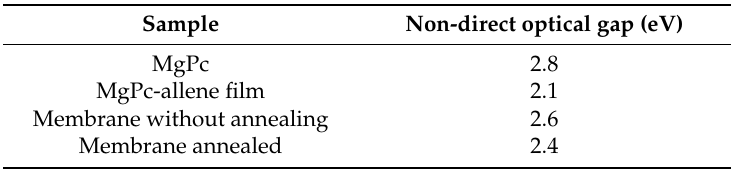
Table 3. Non-direct Tauc optical